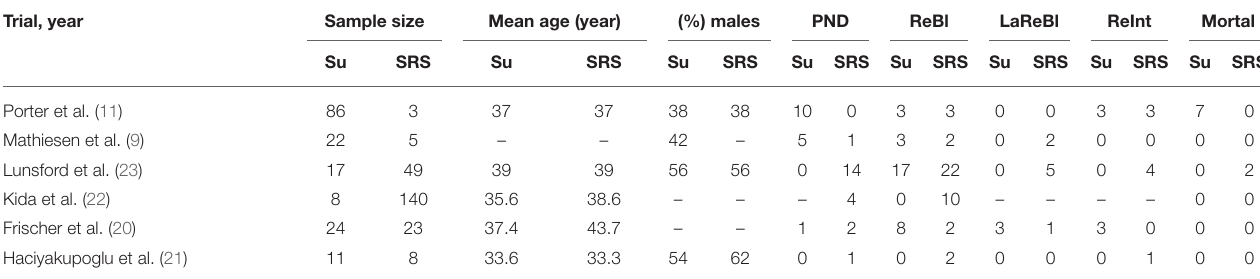
TABLE 1 | Design and baseline characteristics of included trials.